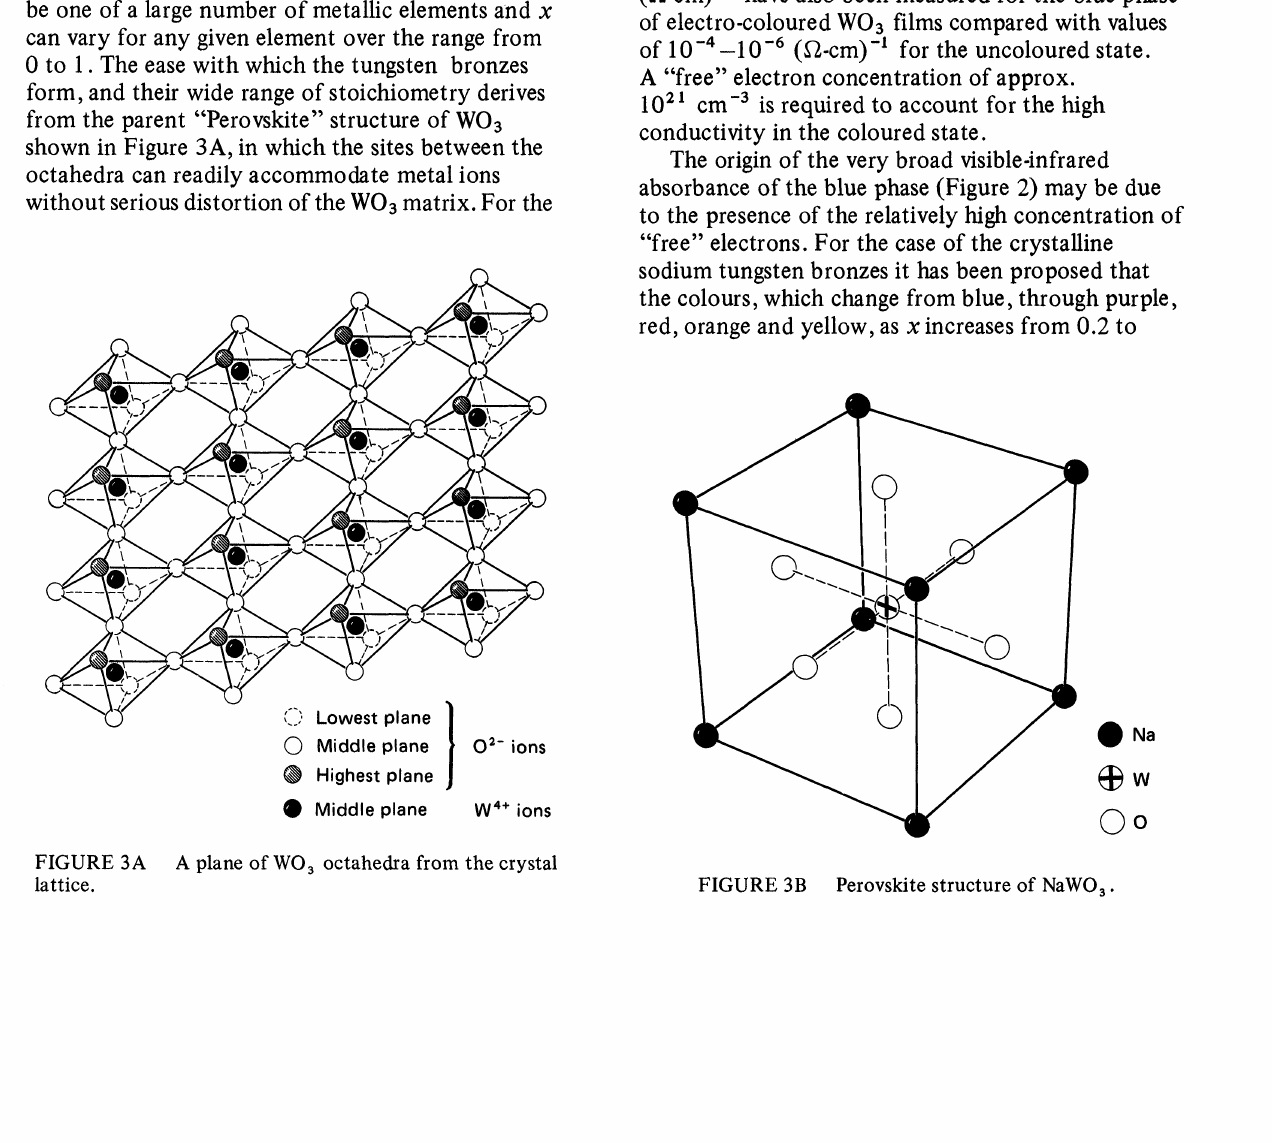
A plane of WO3 octahedra from the crystal lattice.